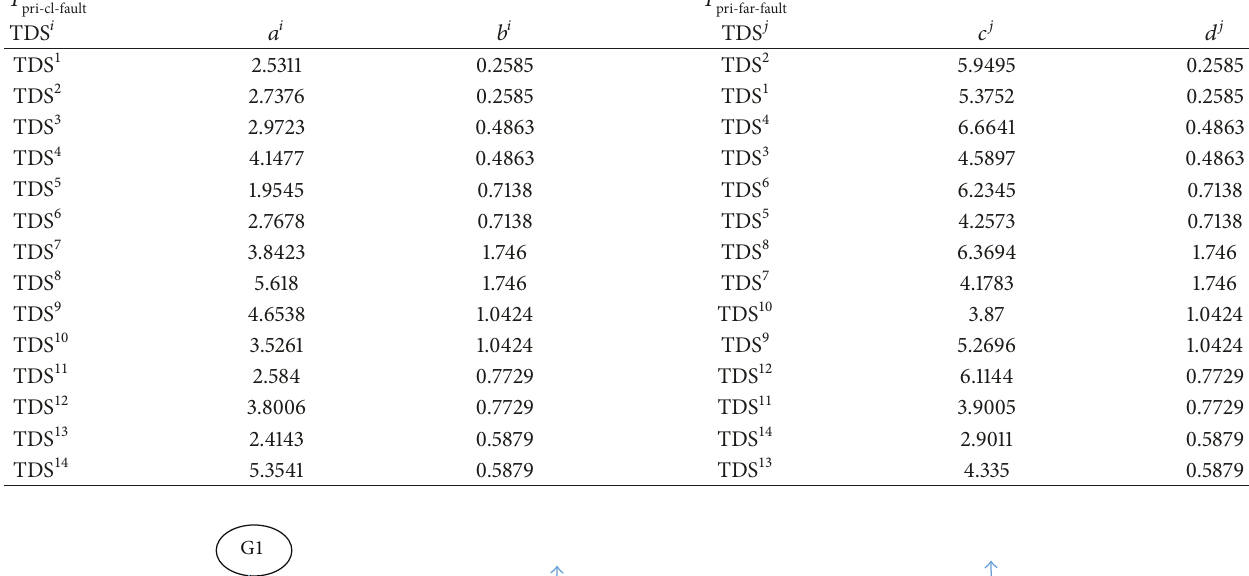
Table 11: Values of constants 𝑎 𝑖 ,𝑏 𝑖 ,𝑐 𝑖 , and 𝑑 𝑖 for Model III.